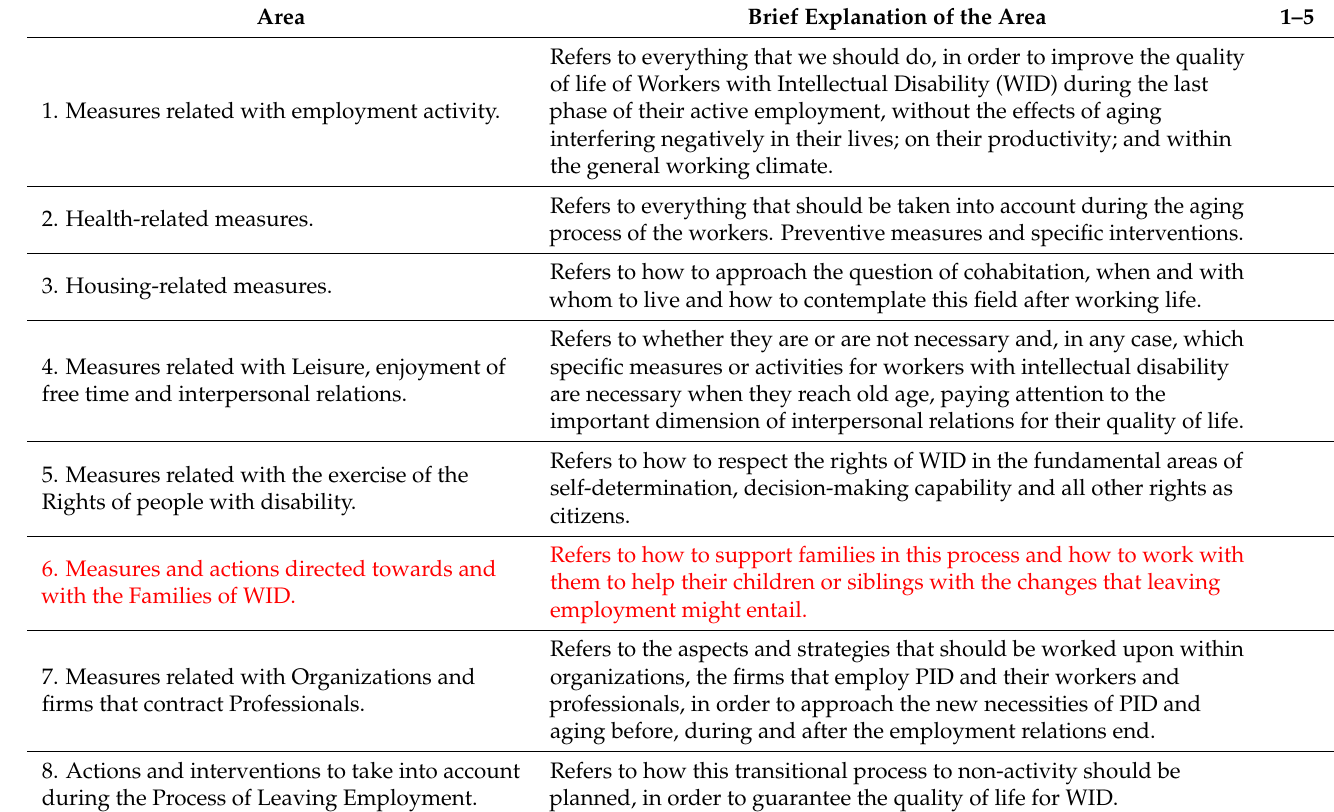
Table 1. Proposed